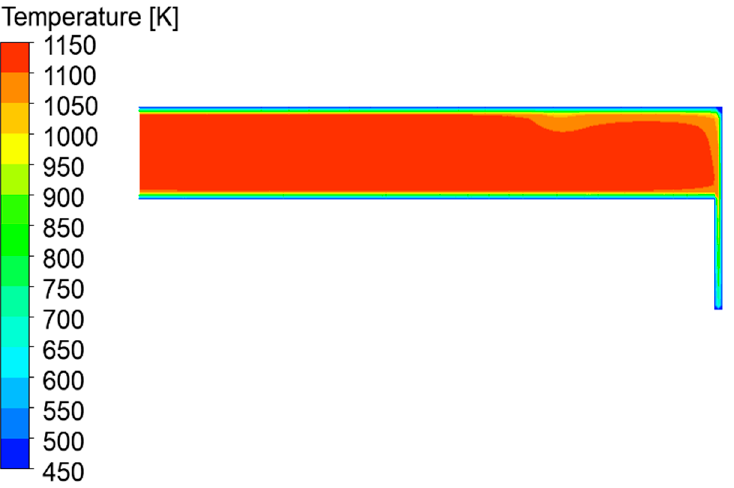
Figure 14. Temperature distribution at 7 CAD BTDC without swirl.